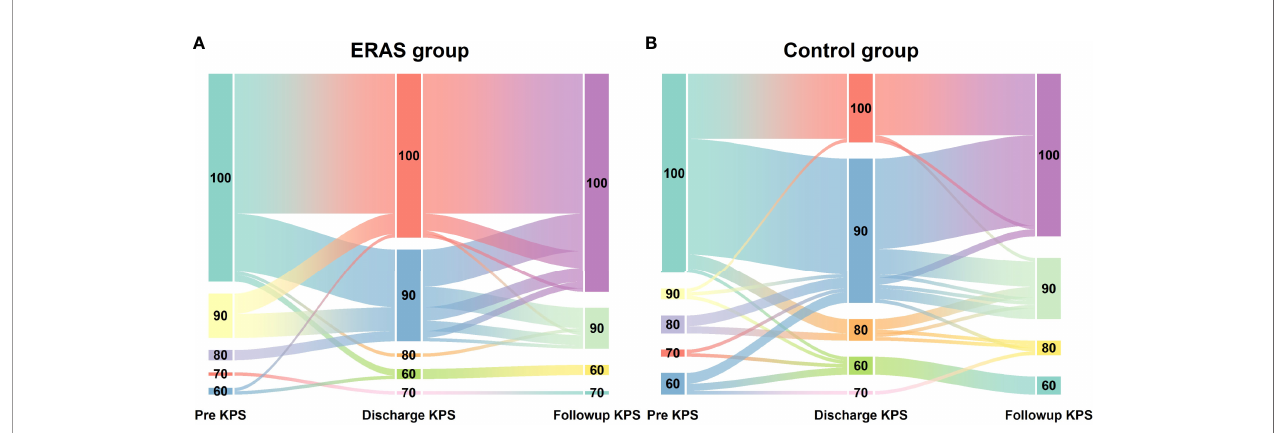
FIGURE 2 | Dynamic changes of KPS scores in glioma patients receiving craniotomy with ERAS protocol (A) and conventional care (B) during